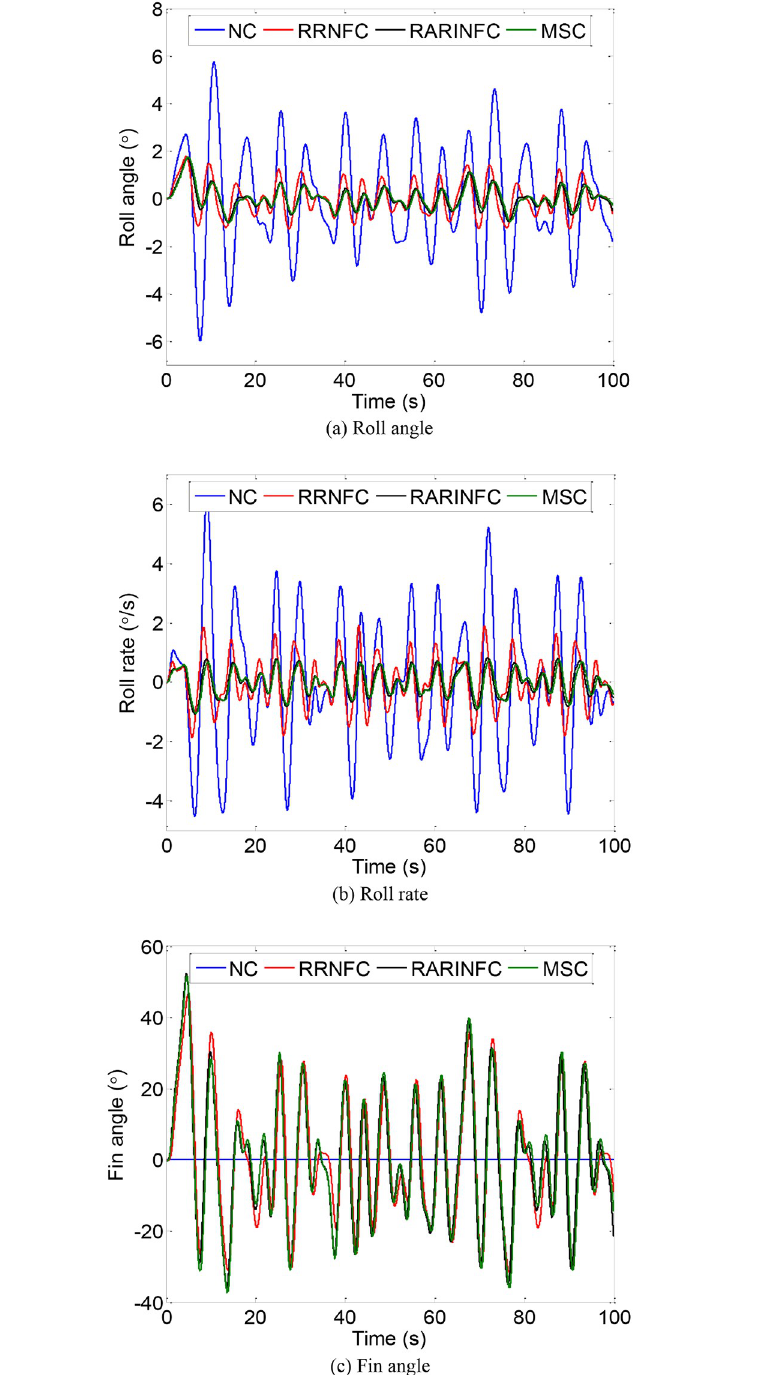
Fig 9. Ship roll motion without and with control. (a) Roll angle. (b) Roll rate. (c) Fin angle. According to the above evaluation indexes, the roll damping performance of the zero-speed fin stabilizer under the three designed controllers is obtained, as shown in Table 3. It can be seen from Table 3 that the three controllers are effective in reducing ship roll motion at zero speed. The RARINFC and MSC have better roll reduction effect than the RRNFC. The anti-